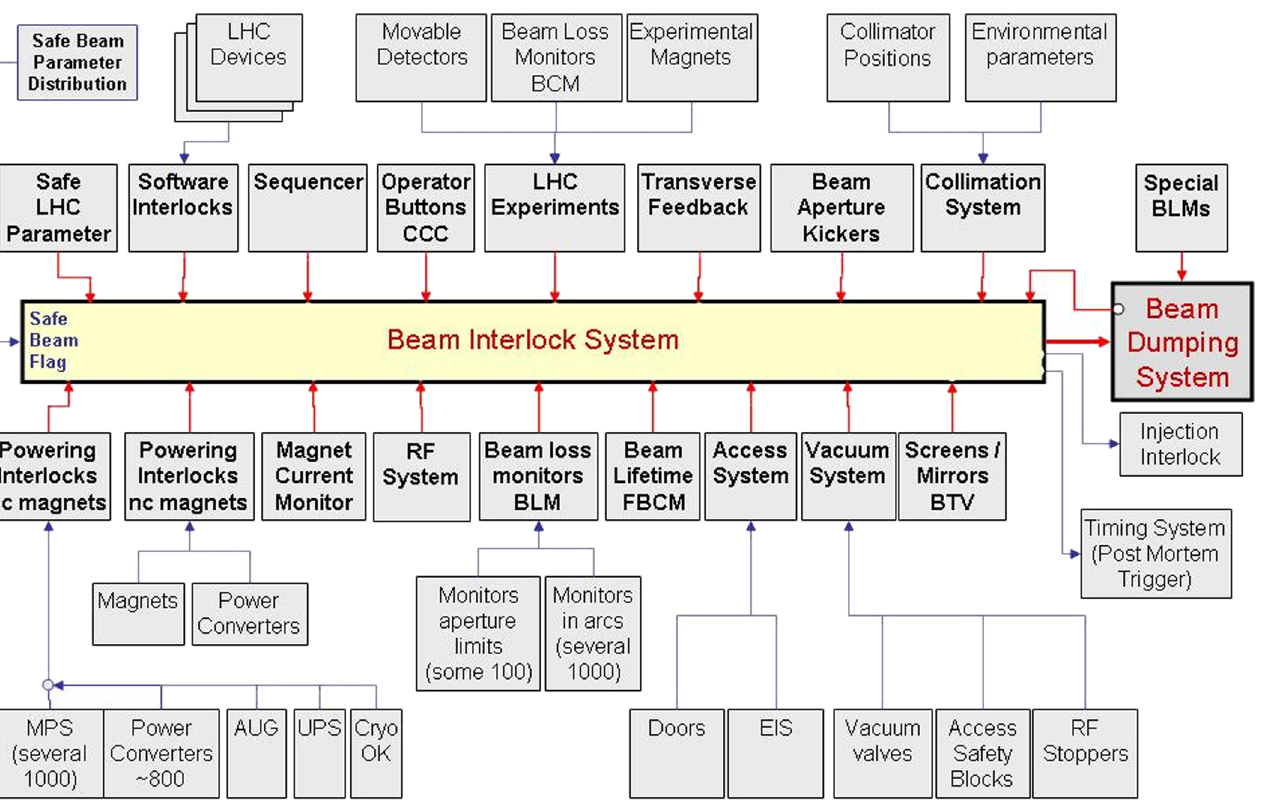
FIG. 1. (Color) Beam interlock system inputs in the